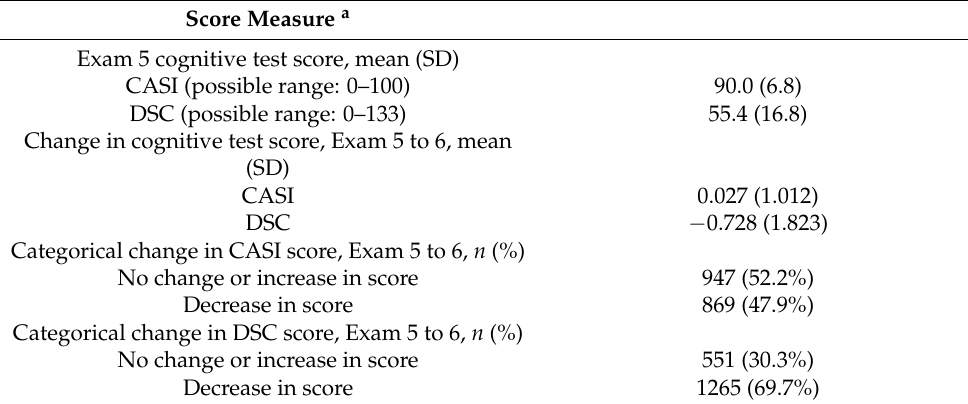
Table 2. Cognitive test scores.